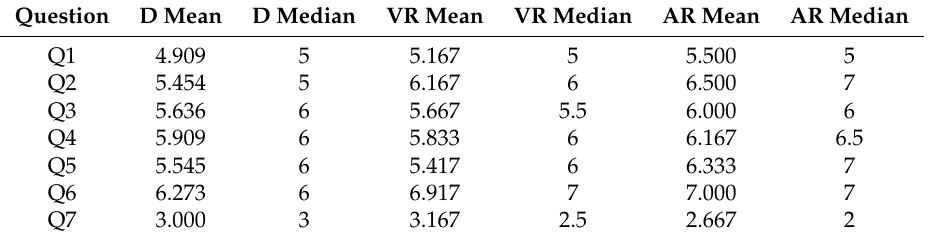
Table 6. Means and medians for each of our questionnaire responses by